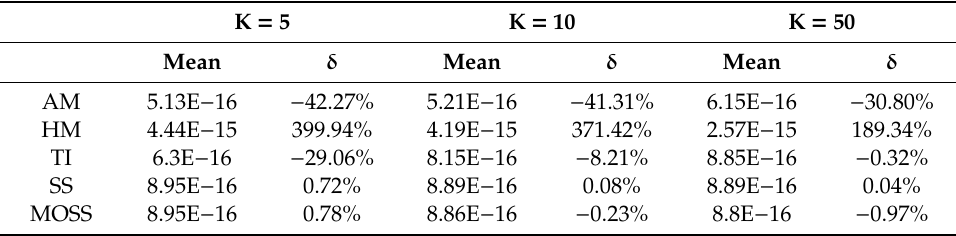
Table 2. BME estimation for the Gaussian model with D = 100 dimensions and α = 0.3 using the arithmetic mean (AM), harmonic mean (HM), thermodynamic integration (TI), steppingstone sampling (SS), and multiple one-steppingstone sampling (MOSS). The mean BME and its relative error ( δ ) are based on 10 independent estimations. The true analytical solution is 8.88E − 16.